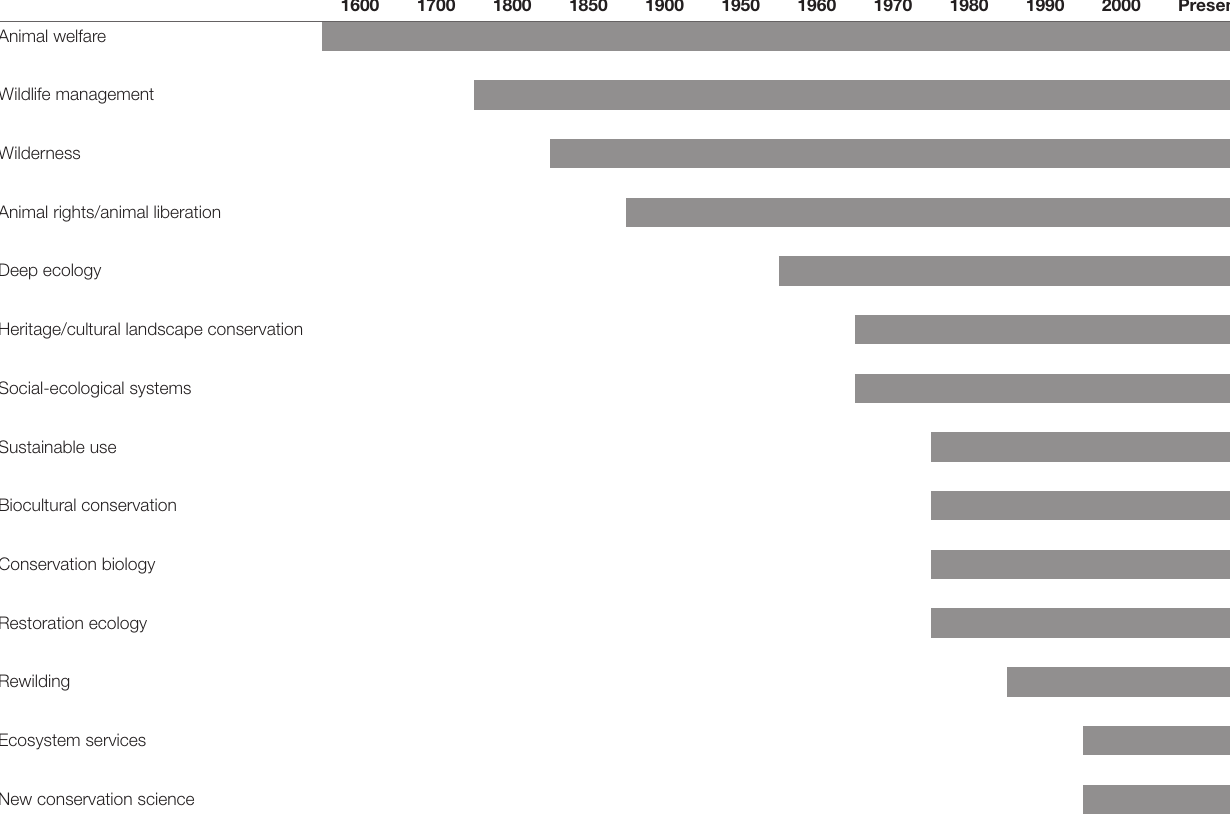
TABLE 1 | Approximate historical timeline of conceptual